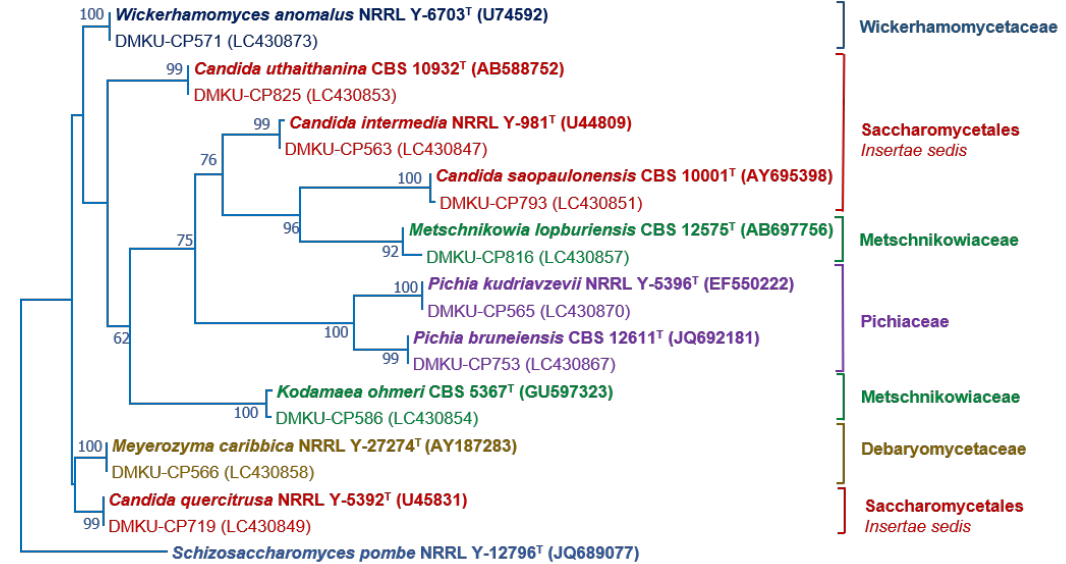
Figure 2. Phylogenetic placement of known species of corn phylloplane ascomycetous yeasts (Phylum Ascomycota, subphylum Saccharomycotina) based on the sequence of the D1 / D2 region of LSU rRNA gene. Reference sequences retrieved from the GenBank database are included. The tree was constructed with the maximum-likelihood method and the GTR evolutionary model. Numbers on the branches represent the bootstrap values ( > 50%) from 1000 random replicates. The scale bar corresponds to a genetic distance of 0.05 substitutions per position. Table 2. Yeast species and respective frequencies detected on corn phylloplane.